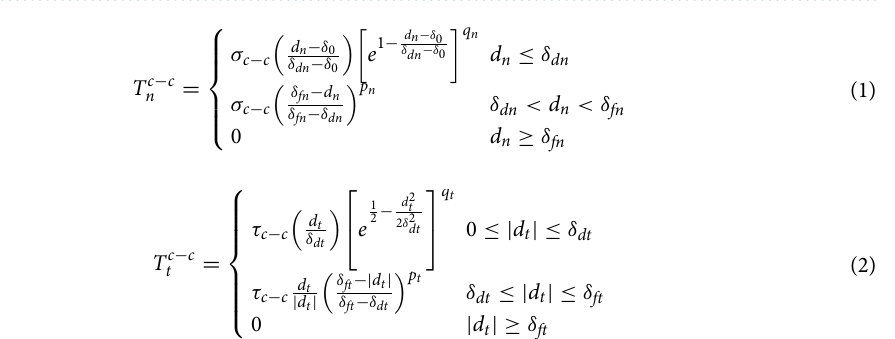
Figure 2. Interaction forces modeling: ( a ) Protrusion traction force at the wound edge, pointing toward the wound center; ( b ) Intercellular interaction at cell–cell junctions was decomposed into normal traction and shear traction; ( c ) Cell-substrate adhesion at the cell-substrate interface was decomposed into normal traction and shear